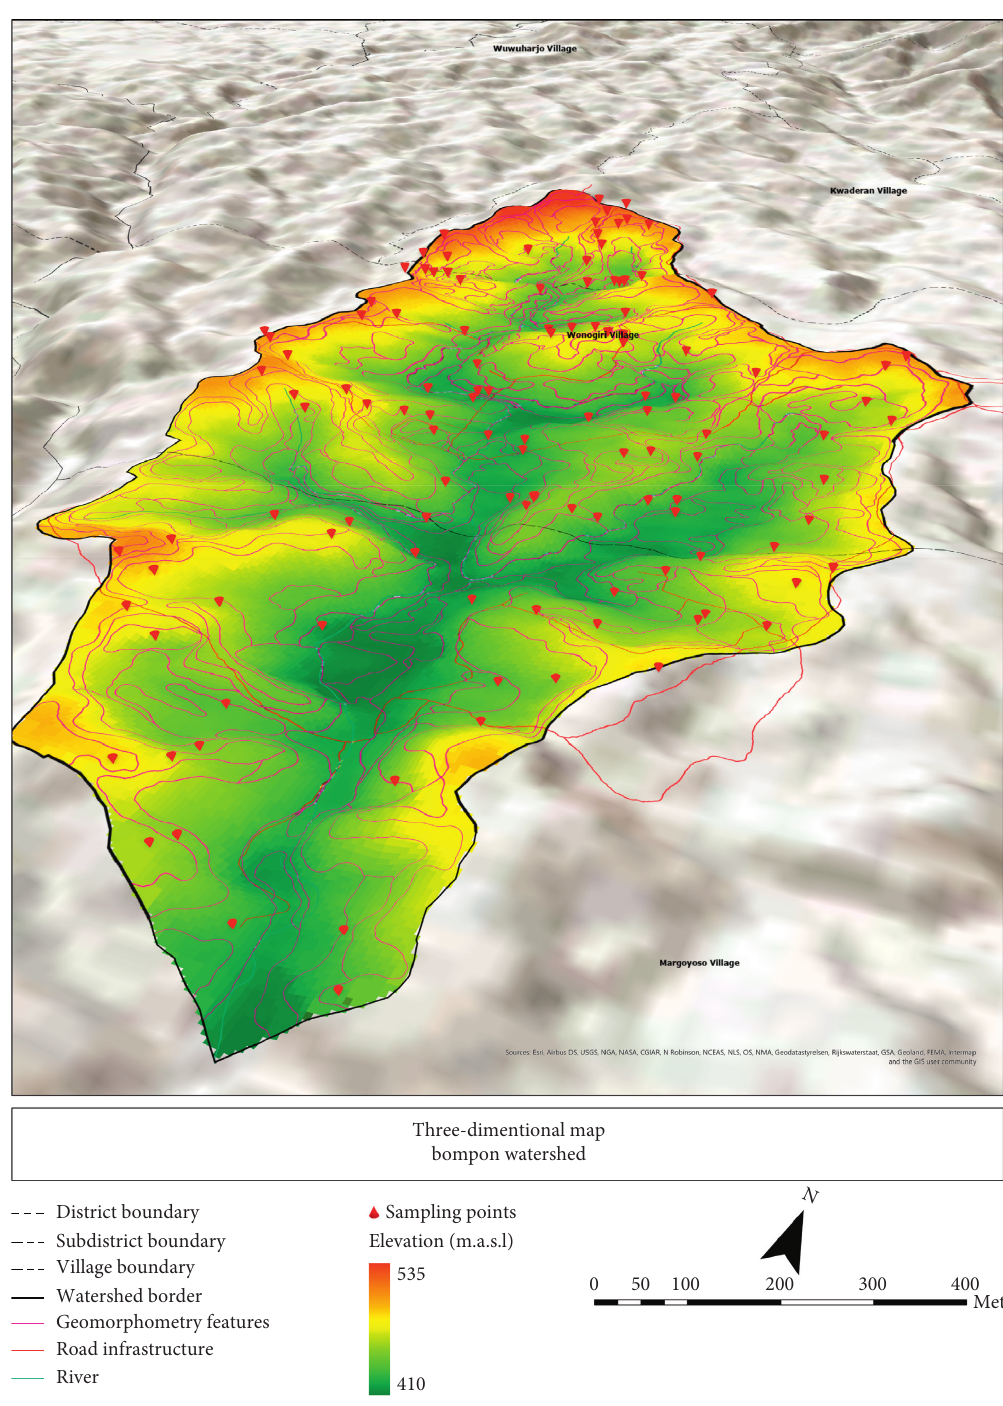
Figure 3: Soil sample distributions in the research area. In total, there are 124 soil sampling points on Bompon watershed. At each location, the soil profile was observed and divided into several layers before taking the soil samples. Differences in sampling density are caused by a difference in the geomorphometry setting on the